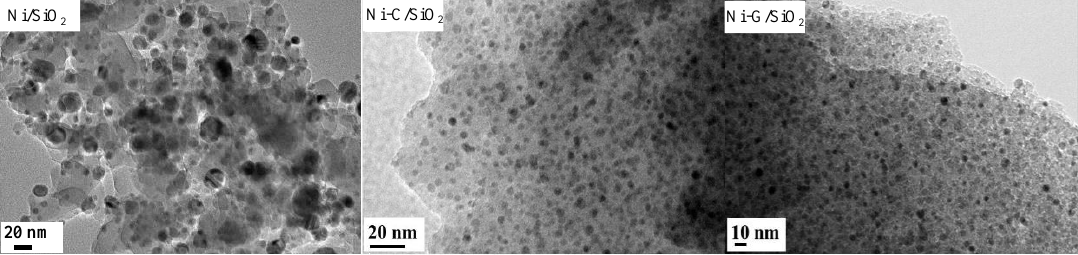
Figure 2. TEM images of the reduced catalysts.